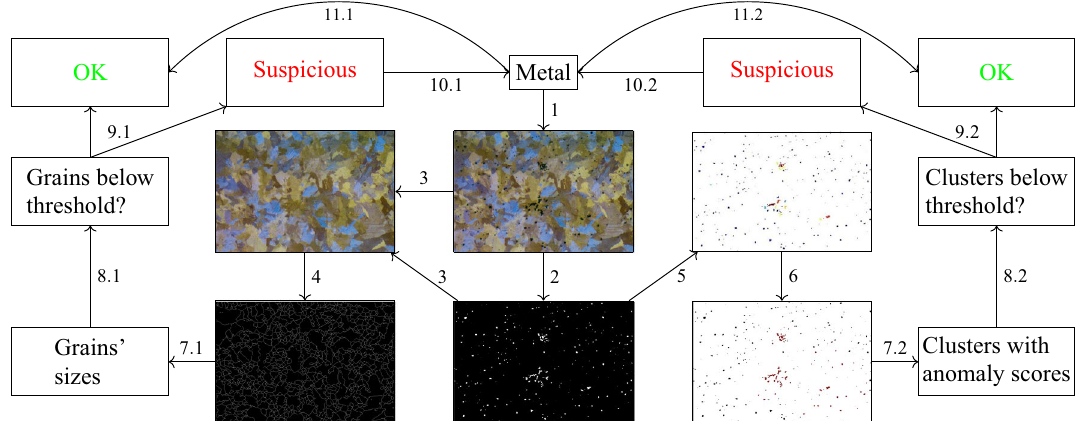
Figure 3. The workflow of our proposed end-to-end model for QM on a given input metal. First, in 1, metallographic imaging is performed. Then, in 2, semantic segmentation for impurities is carried out. Using the metallographic image and the mask of segmented impurities, the impurities are inpainted in 3, creating a ‘clean’ metallographic image. Next, grains’ boundaries are semantically segmented over the metallographic image without the impurities in 4. In 5, spatial and shape anomaly detection measures are calculated from the segmented impurities, and in 6, the anomalies are clustered based on area anomaly. In 7.1, the grains’ sizes are calculated, and in 7.2, each cluster of anomalous impurities receives a numeric value representing its anomaly score. In 8.1 and 8.2, statistics based on these values are calculated and compared against pre-set or learned corresponding thresholds. These thresholds determine in 9.1, 9.2 whether the input metal is OK (under the threshold) or suspicious (over the threshold). If one of the values exceeds the threshold, a suitable physical test is performed (10.1, 10.2) on the input metal in the advised area from the model. If the physical test establishes no fault in the material, the sample is set as OK and the corresponding threshold is tuned respectively in 11.1 and 11.2.